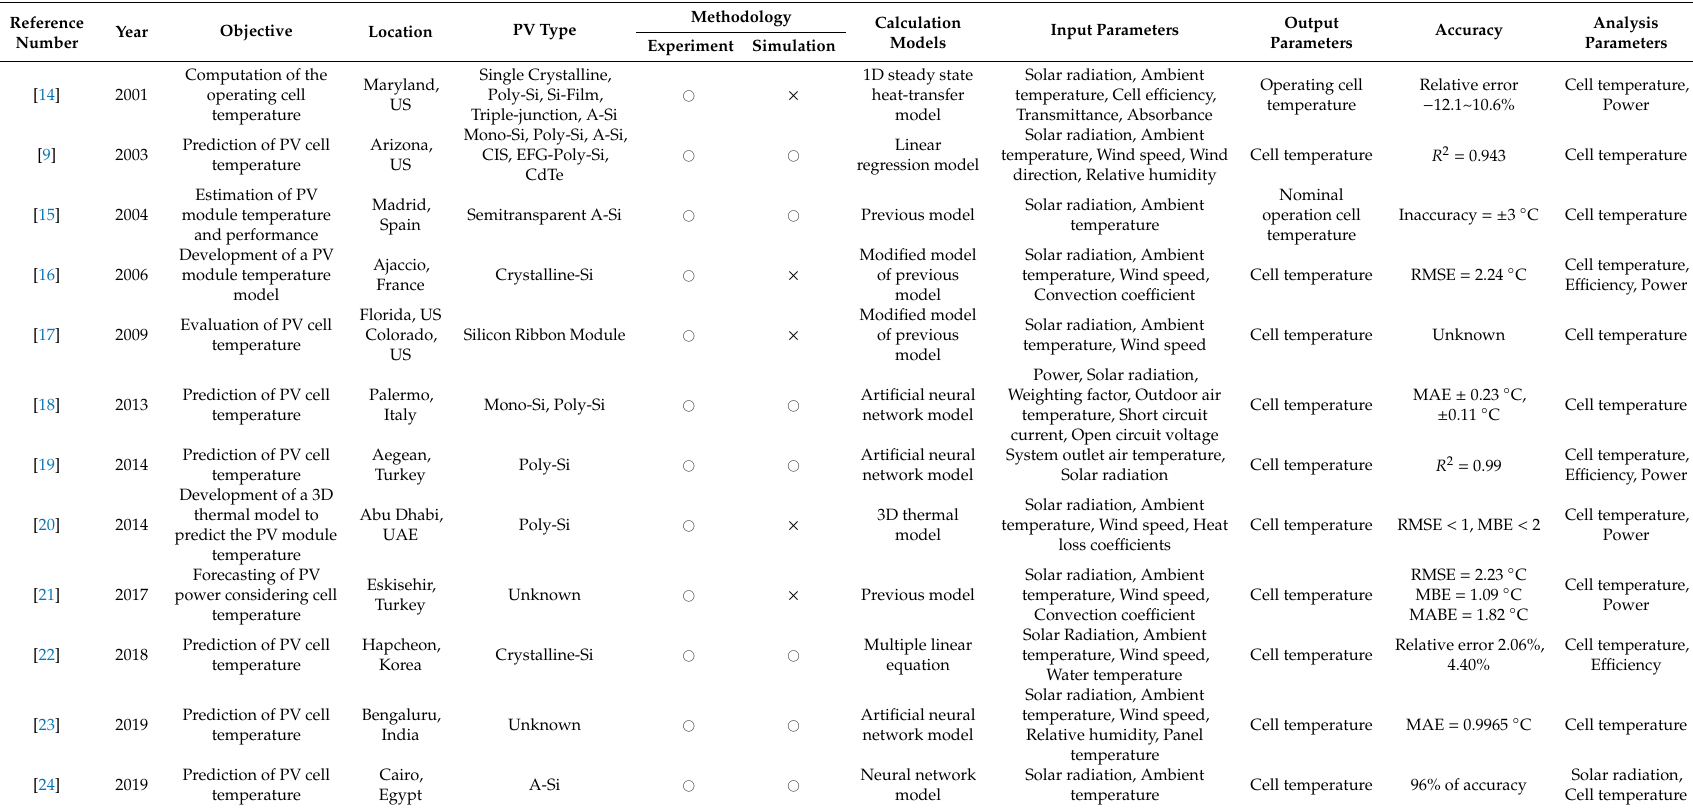
Table 1. Literature reviews of photovoltaic (PV) cell (or module) surface